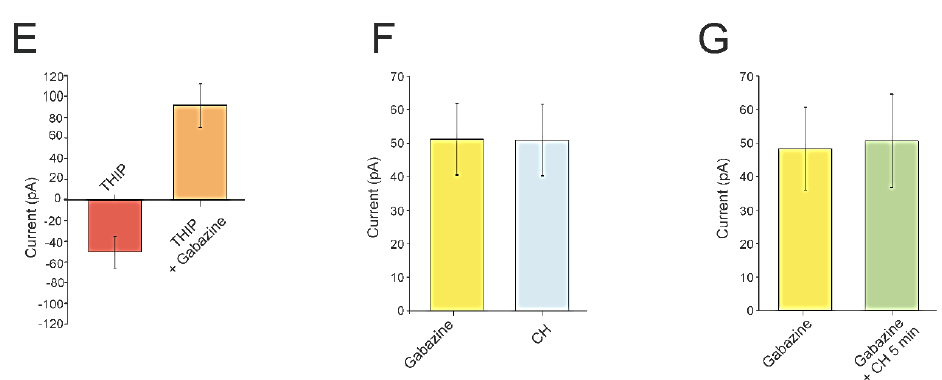
Figure 3. Effects of gabazine and cumene hydroperoxide (CH) on the holding current of pyramidal neurons from the motor cortex in infantile rats. ( A ) . The application of gabazine 20 μM ( n = 6) in the presence of glutamatergic antagonists blocked the spontaneous inhibitory postsynaptic currents (sIPSC) and revealed a tonic current mediated by the gabazine (GABA A ) receptor (30 pA for the illustrated neuron). ( B ). Changes in the holding current after THIP application (an agonist of GABA A extrasynaptic receptors) and after THIP plus gabazine in the same cell ( n = 6). These experiments were carried out to check the presence of extrasynaptic receptors in this pool of neurons. ( C ). Effect of CH on the membrane current. Note that the application of CH in the presence of CNQX and AP5 produced an outward shift in the holding current when the holding potential was held at −7 0 mV ( n = 6). ( D ). Effects on the membrane current during gabazine and CH consecutive application. Note that, in the same cell, no additional effects on the holding current were observed after CH administration. E-G. Histograms showing the mean values ( n = 6) of the changes in holding current after THIP and then after THIP plus gabazine in the same cells ( E ), after gabazine and after CH administration in different cells ( F ), and after gabazine and then after gabazine plus CH administration in the same cell ( G ). Note that no significant differences between both groups were found in F-G. THIP, Tetrahydroisoxazolo [5,4-c] pyridin-3-ol hydrochloride; CNQX, 6-cyano-7-